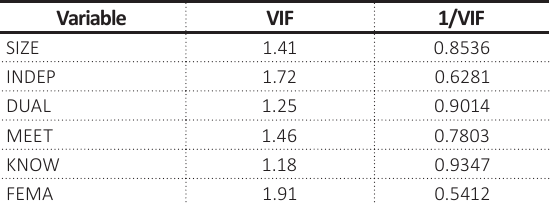
Table 4. VIF of the